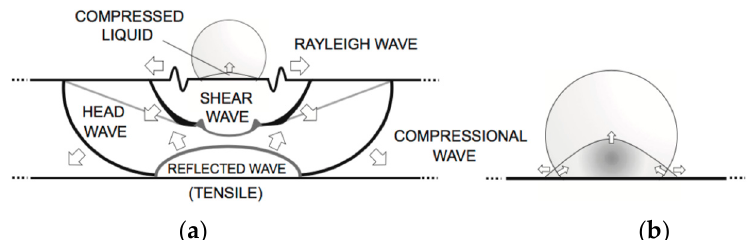
Figure 8. Liquid droplet–solid surface impact interaction, showing shockwave behaviour (from [20]). ( a ) Illustrates the three waves that develop following the droplet collision; ( b ) shows the lateral jetting upon movement of the contact boundary ahead of the shock wave in the drop initiating a release wave across the solid surface.